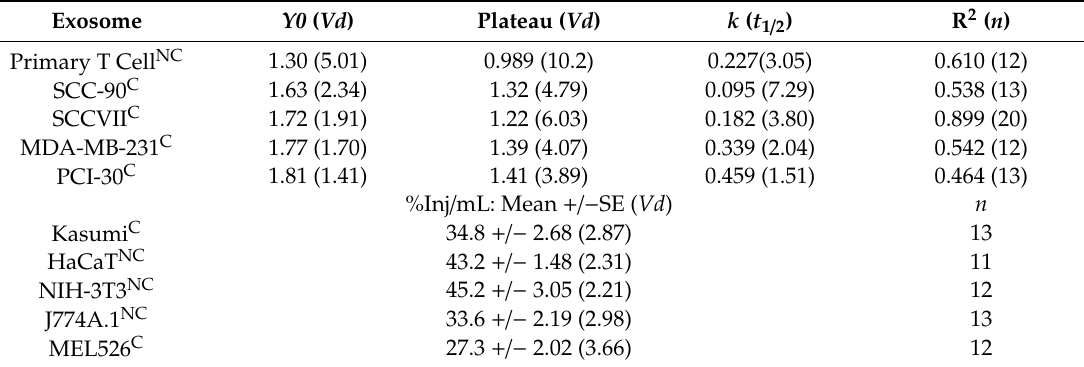
Figure 3. Clearance of exosomes from blood demonstrated two major patterns: phase decay, as exemplified by SCCVII (mouse tumor) exosomes and no change with time as exemplified by MEL526 (human melanoma) exosomes. Table 2. Serum Pharmacokinetics and Estimated Volumes of Distribution a.